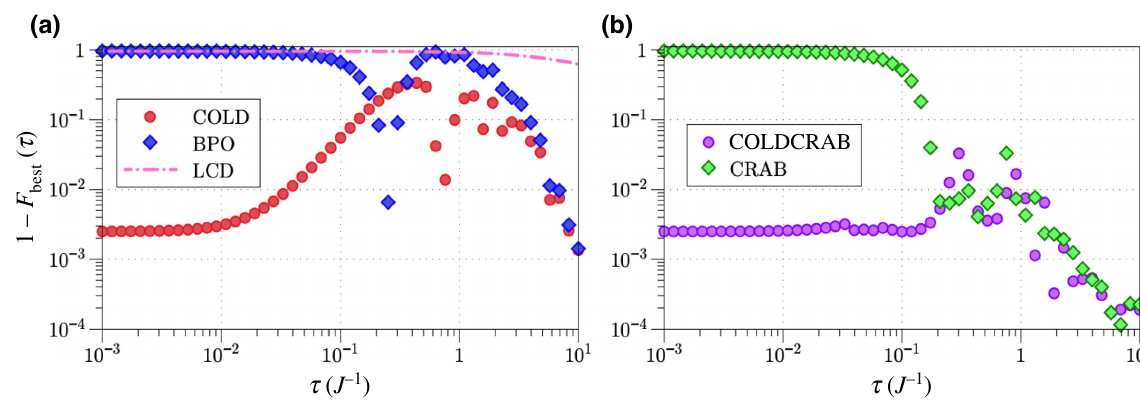
FIG. 2. Optimization of the annealing protocol for the Ising model given by Eq. (23) for N = 5 spins. (a) A comparison of final state fidelities (plots show 1 − F ) for different driving times using the optimal control technique BPO (blue diamonds), first-order LCD (pink dash-dot line), and COLD (red circles). The same is shown in (b) for CRAB (green diamonds) and COLDCRAB (purple circles). CD-enhanced techniques (COLD and COLDCRAB) introduced in this work show a clear convergence to good fidelities at short driving times. All results are for the best (lowest) fidelity achieved over 500